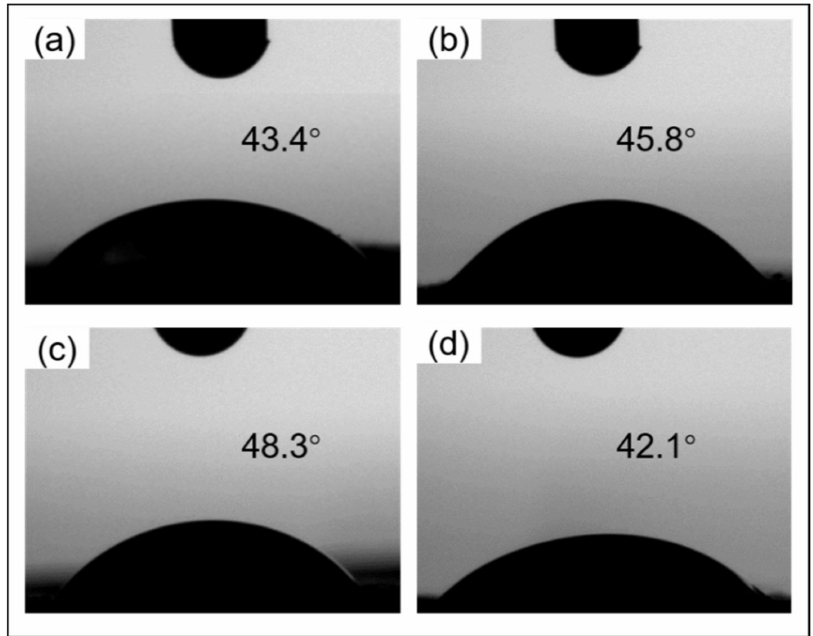
Figure 8. Contact angle images of nanofibers via co-axial needle centrifugal spinning. Core and shell layers in these four samples: ( a ) Sample G was 7 w / v % PEO and 2:1 CCS/PEO; ( b ) Sample H was 6 w / v % PEO and 2:1 CCS/PEO; ( c ) Sample I was 7 w / v % PEO and 1:1 CCS/PEO; and ( d ) Sample J is 6 w / v % PEO and 1:1